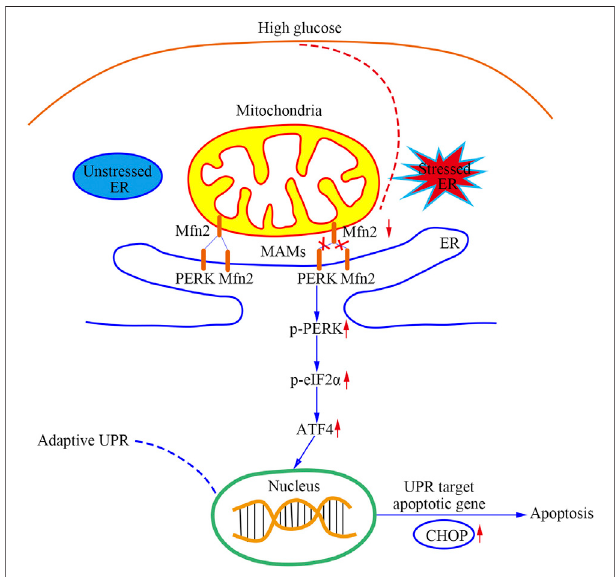
FIGURE8| AschematicsummaryoftheeffectsofMfn2-PERKsignaling pathwayonpodocyteinjuryandapoptosiscausedbyHG-inducedMAMsand mitochondrial